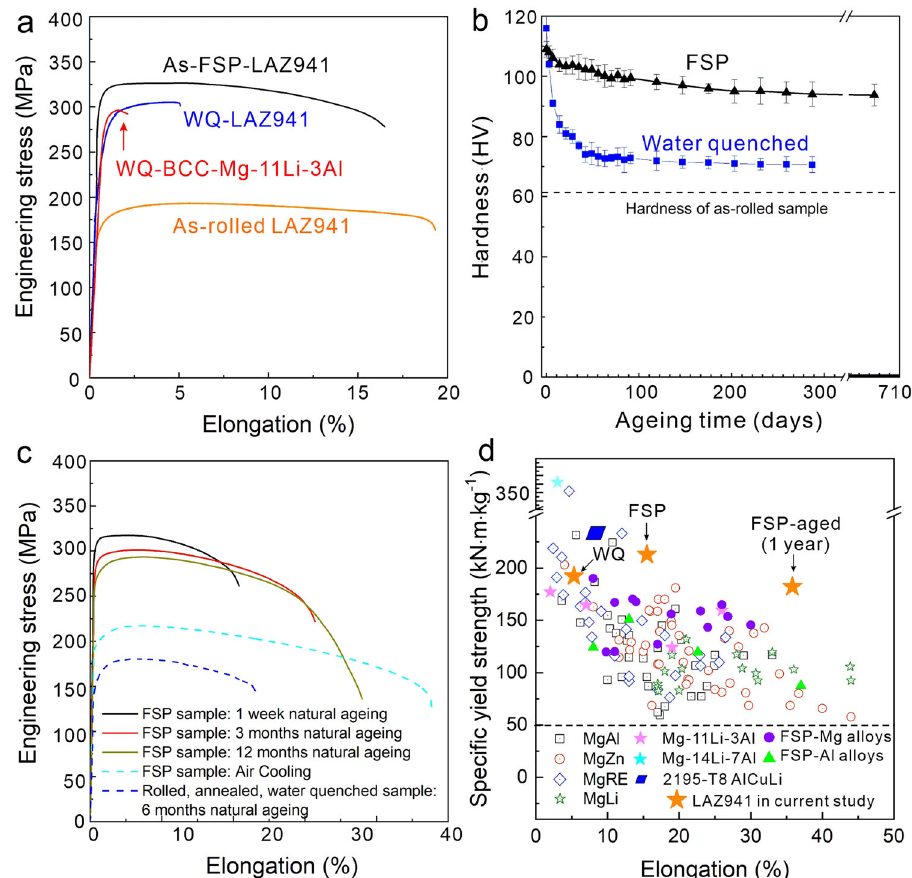
Fig. 3 Mechanical properties. a Tensile stress – strain curves of LAZ941 alloy in the as-rolled, FSP and WQ states in contrast to that of WQ – Mg-11Li – 3Al benchmark. b Hardness of WQ- and FSP-LAZ941 samples during natural ageing up to 2 years. c Tensile stress – strain curves of FSP-LAZ941 alloy after natural ageing for 1 week, 3 and 12 months, in contrast to that of as-FSP-LAZ941 (air-cooled and no liquid CO 2 applied) and WQ-LAZ941 alloy after natural ageing for 6 months. d Comparison of speci fi c yield strength and elongation of WQ- and FSP-LAZ941 alloy with other Mg alloys, high-strength AlCuLi alloy, FSP – Mg and FSP – Al alloys in tensile test 2,5,11,12,27 – 45